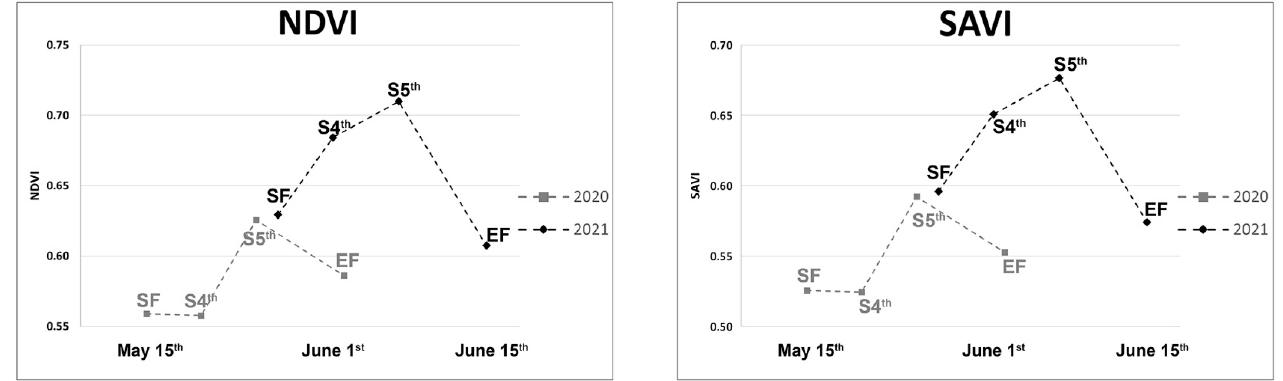
Figure 3. Evolution of five vegetation indices from the considered M. alba fields on the four previously defined dates: SF = start of feeding, S4th = start of fourth instar, S5th = start of fifth instar, EF = end of feeding.